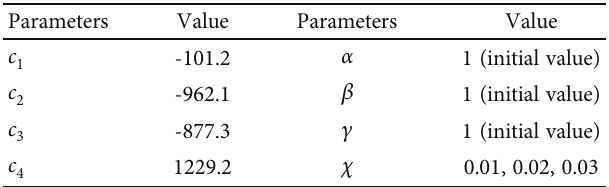
Figure 3: Stress ratio-anisotropy index curve ( θ =60 ° ) ( ∗ N an anisotropy index related to the distribution of contact normal. N N 1 and 2 are the maximum and minimum densities of contact normal, respectively.) Table 1: Parameters for the evaluation of anisotropic hypoplastic model (Karlsruhe sand) [8,